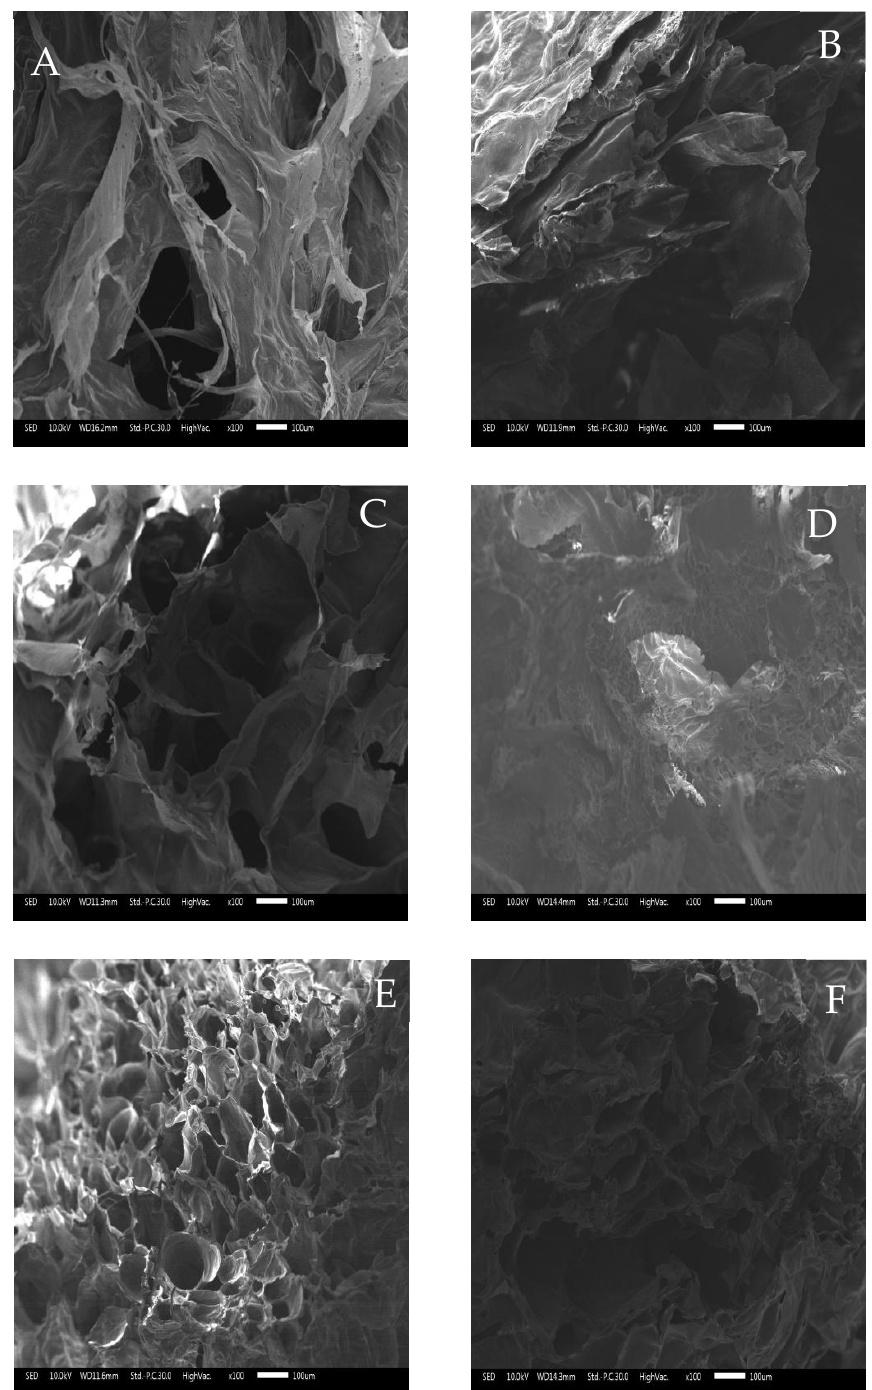
Figure 5. Morphology of hydrogels. ( A ) S0; ( B ) S1; ( C ) S2; ( D ) S3; ( E ) S4; ( F ) S5. The scale bars correspond to 100 μ m. The ratios of gellan gum and soybean isolate were S0 (0.3:0); S1 (0.3:1); S2 (0.3:2); S3 (0.3:3); S4 (0.3:4); S5 (0.3:5).